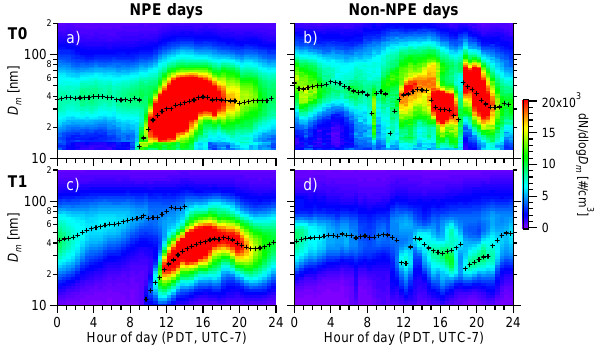
Figure 5. Diurnal size distributions of the particle number concen- tration at the (a, b) T0 and (c, d) T1 sites during NPE days (left panel) and non-NPE days (right panel). Black crosses correspond to the modal diameters fitted by log-normal distributions.